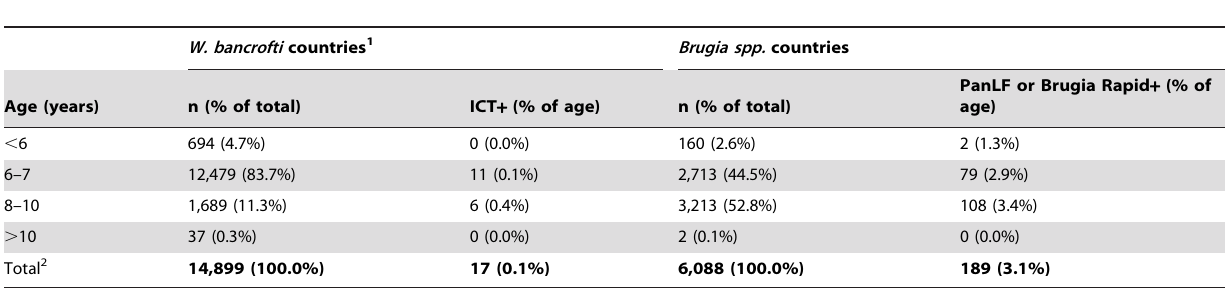
Table 6. TAS results by age for school surveys in W. bancrofti and Brugia. spp.